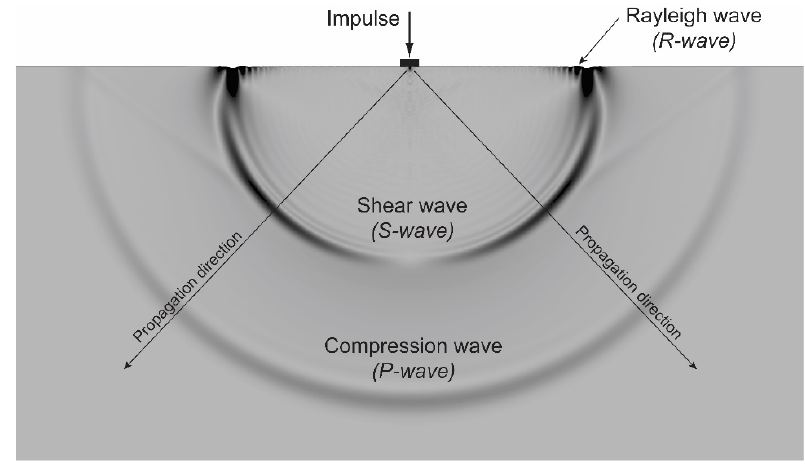
Figure 1. Schematic illustration of wave propagation in a